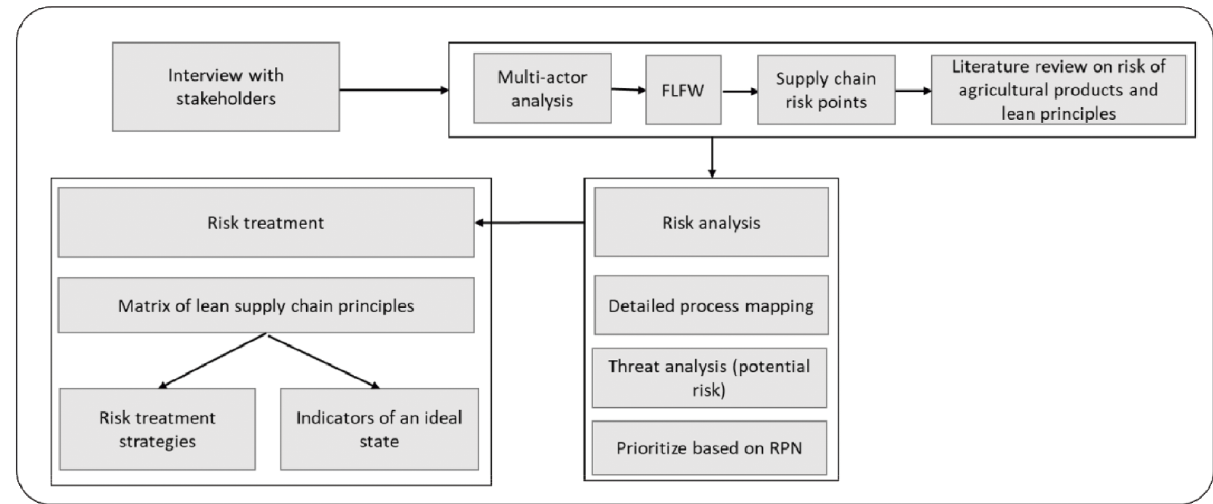
Figure 3. Research